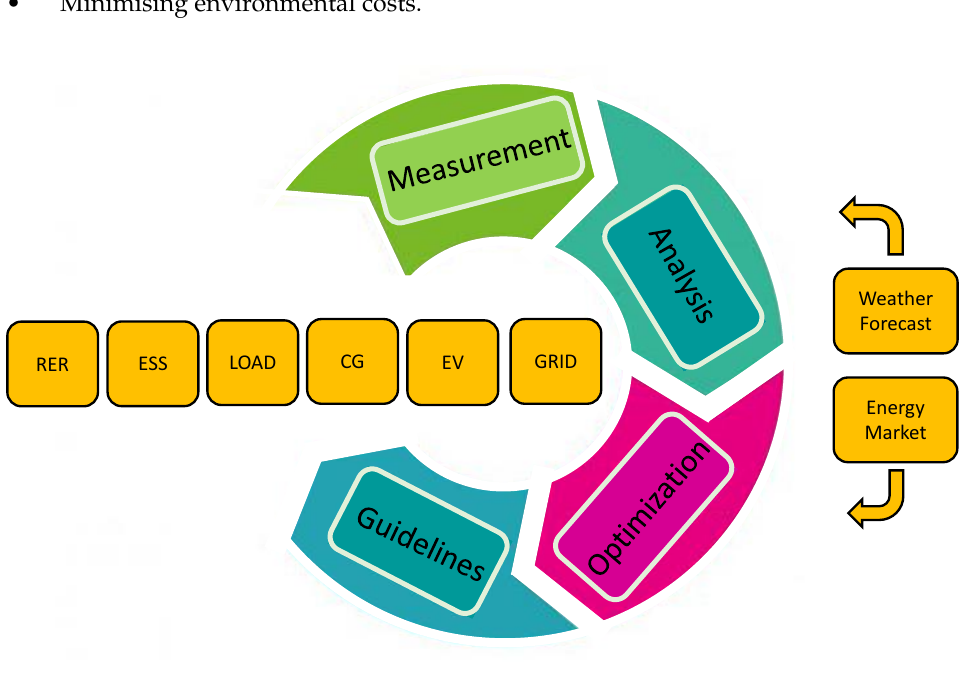
Figure 11. EMS Architecture.